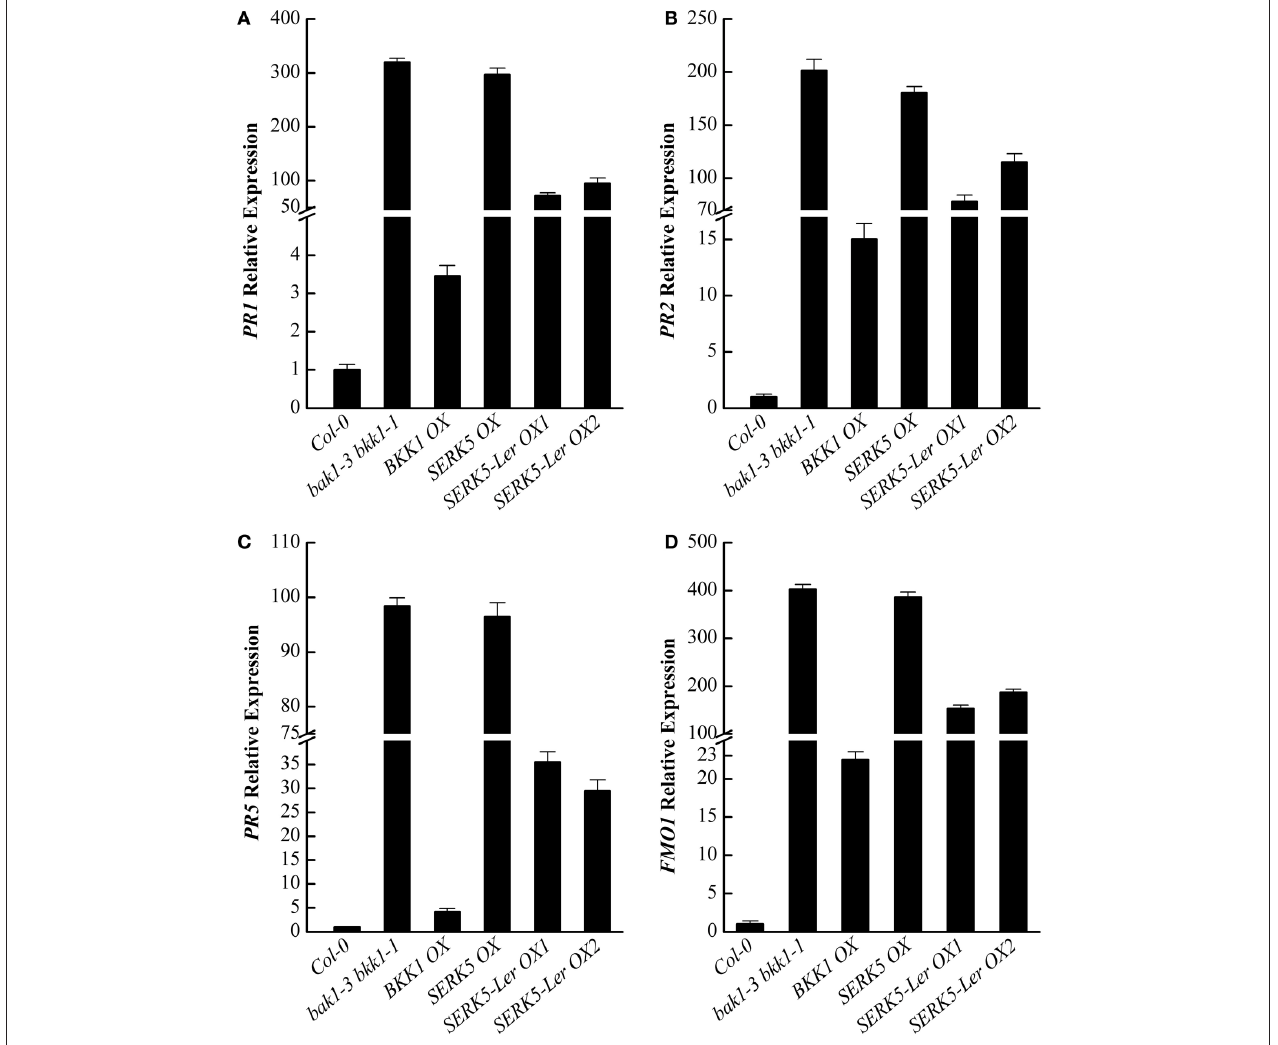
FIGURE 11 | qRT-PCR analysis of the PR1 , PR2 , PR5, and FMO1 gene expression levels in WT, bak1-3 bkk1-1 and bak1-3 bkk1-1 lines overexpressing SERKs . (A–D) Defense-related genes PR1 , PR2 , PR5, and senescence-related gene FMO1 were down-regulated in bak1-3 bkk1-1 when SERK5 -L er is